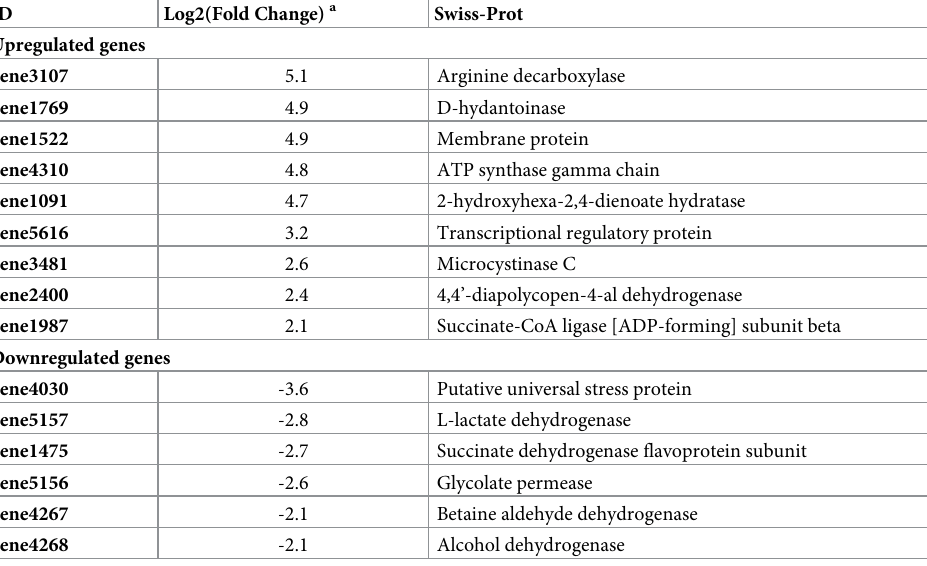
Table 2. Highly differentials expressed genes in B . aryabhattai during its interaction with Arabidopsis